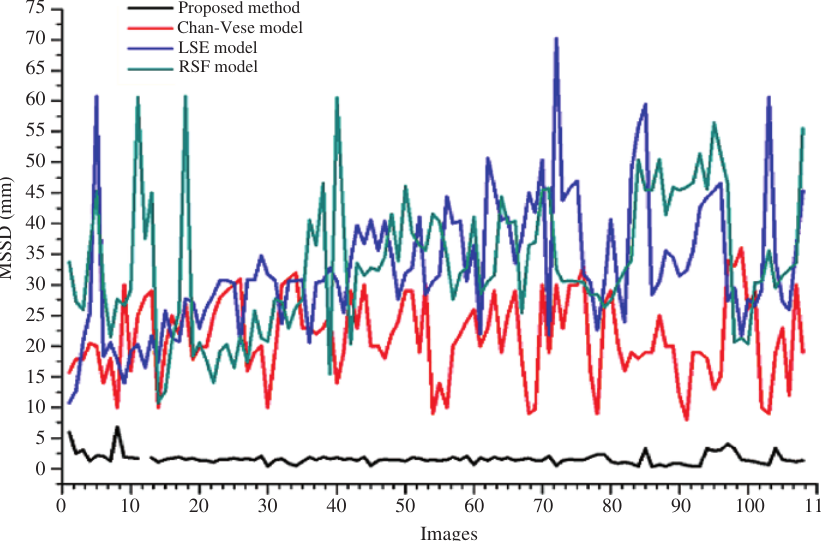
Figure 7: Comparison of Performance Evaluation Results using MSSD.